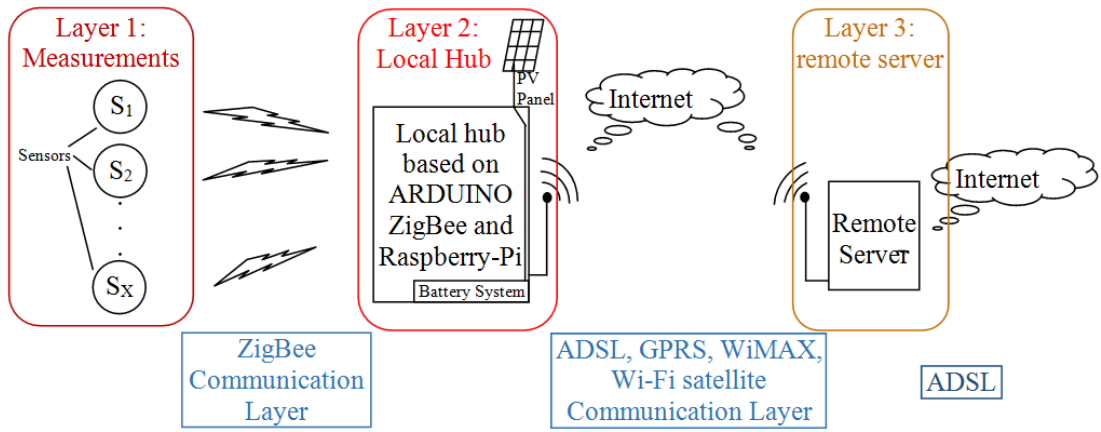
Figure 1. Block Scheme of the measurements system: the layered